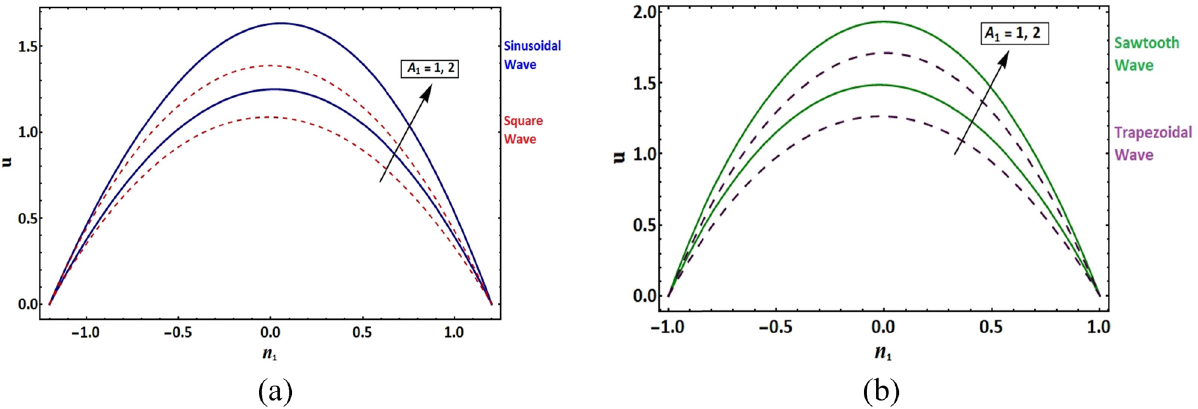
= 0.1, Sc = 0.5, K = 3, Sr = 0.5, A 1